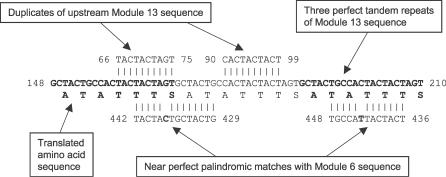
Key Features of Module 6 and 13 SequencesThe sof sequence AF139751 is presented as an example to show nontandem direct repeats in Module 13 (top strands), tandem direct repeats in Module 13 (middle strand), and complementary inverted repeats in Module 6 (bottom strands). The predicted amino acid sequence of nt positions 148 to 210 demonstrates the Ser-, Thr-, and Ala-codon–rich quality of this region.